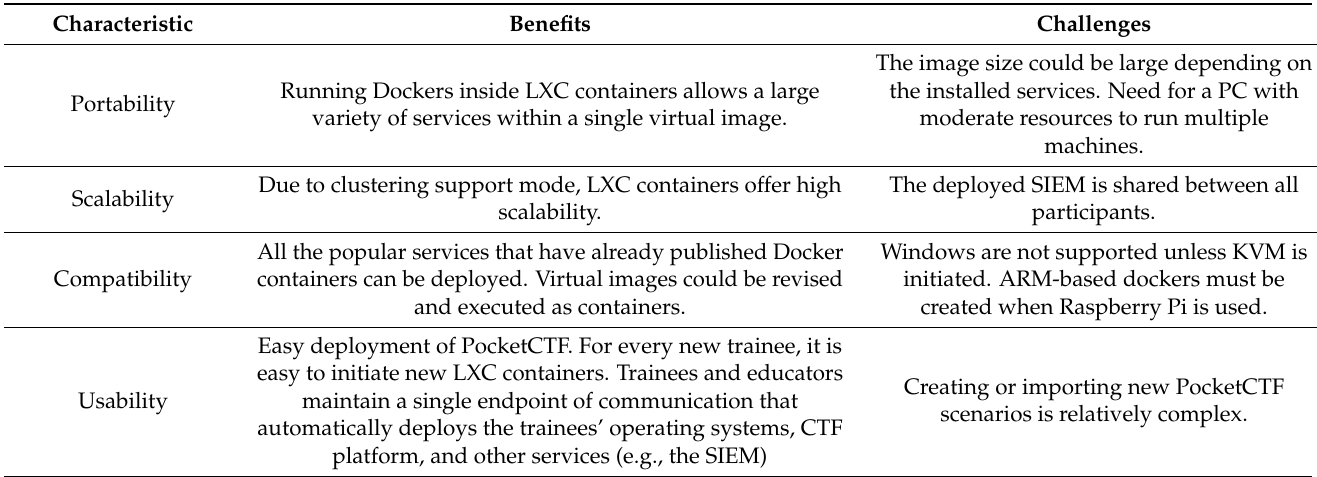
Table 5. Benefits and challenges of